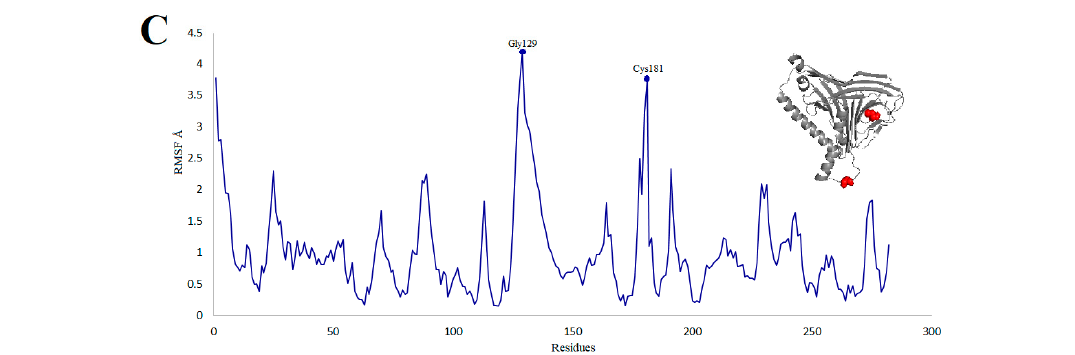
Figure 6. MEV structural flexibility results: ( A ) Cartoon representation of top 10 final models showing negligible fluctuation throughout; ( B ) MEV residue–residue interaction/contact map. The interactive area is represented in the central panel; ( C ) RMSF plot representing the obvious fluctuations of MEV residues during simulation. The highest fluctuations were depicted by residues Gly129 and Cys181. Both are present in loops of MEV and highlighted with red color spheres on the MEV structure (gray).